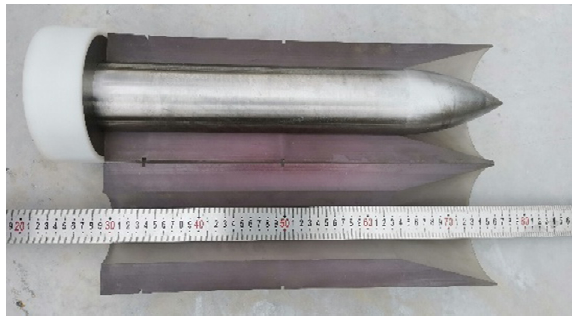
Figure 7. The projectile with a sabot.